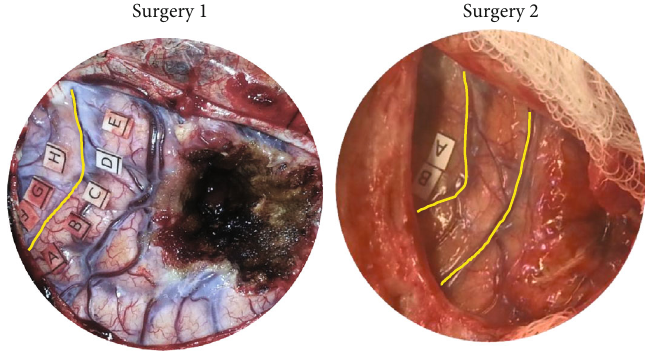
Figure 2: Plasticity, distant recruitment. The yellow box highlights the same portion of the left postcentral gyrus. This fi gure demonstrates distant recruitment plasticity of Patient 1. At surgery 1, there was complete activation of the exposed postcentral gyrus (Points A-E). At surgery 2, stimulation could no longer elicit function in the identical region of the postcentral gyrus. However, Patient 1 had no sensory de fi cits at surgery 2. Thus, the function that had been in the postcentral gyrus at surgery 1 had reorganized distally (outside of the operative fi eld) by surgery 2 to preserve sensory function. This is a prototype of distant recruitment plasticity.